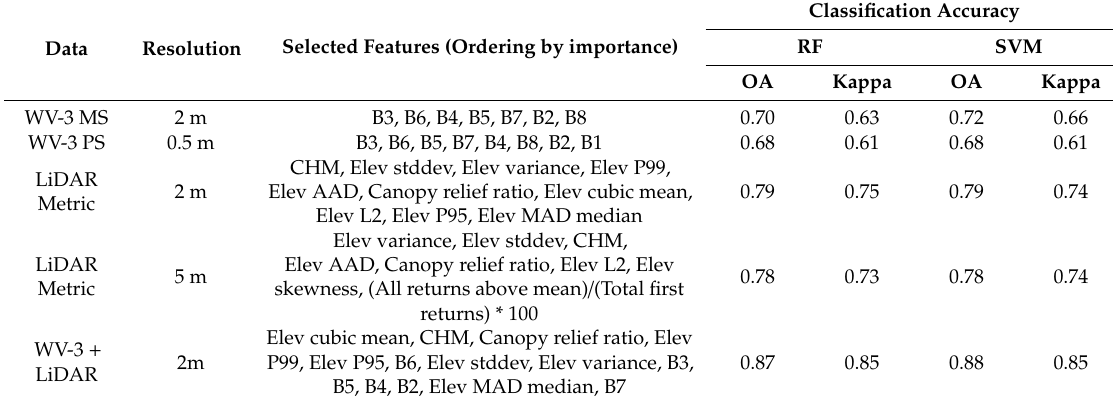
Table 3. Selected features and corresponding classification accuracy.